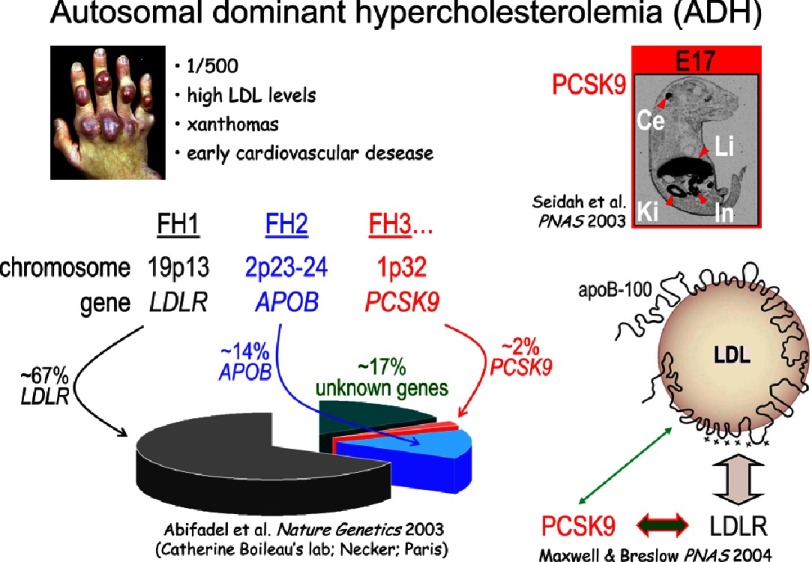
Schematic representation of the incidence of FH-1, 2 and 3 mutations and a model emphasizing the mutual binding of the LDLR, apoB and PCSK9.The tendon xanthomas seen in FH patients are shown on the top left corner.